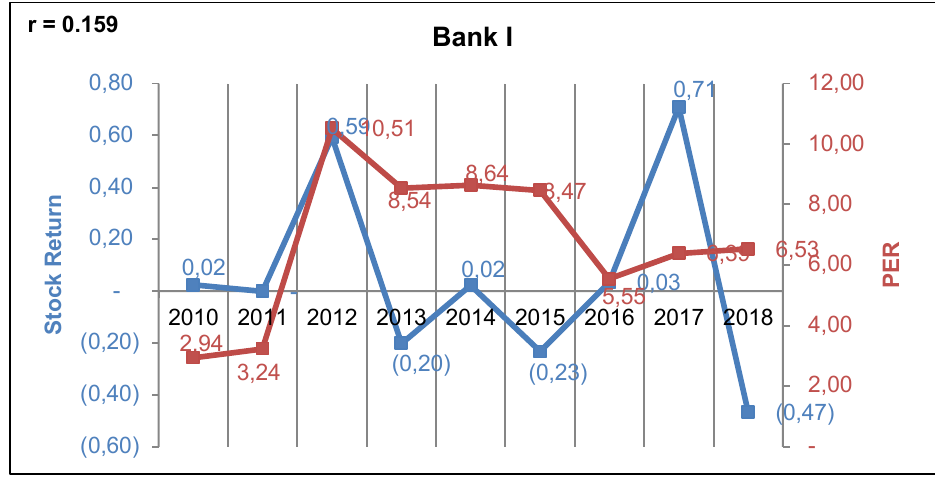
Figure 8: For Bank I